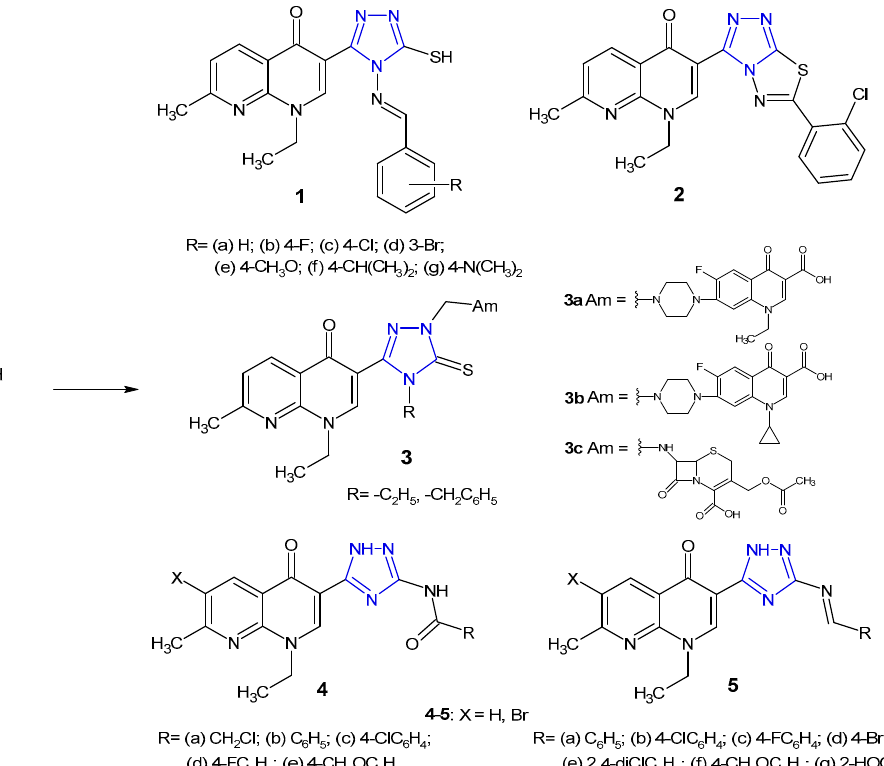
Figure 4. 1,2,4-triazole analogues of nalidixic